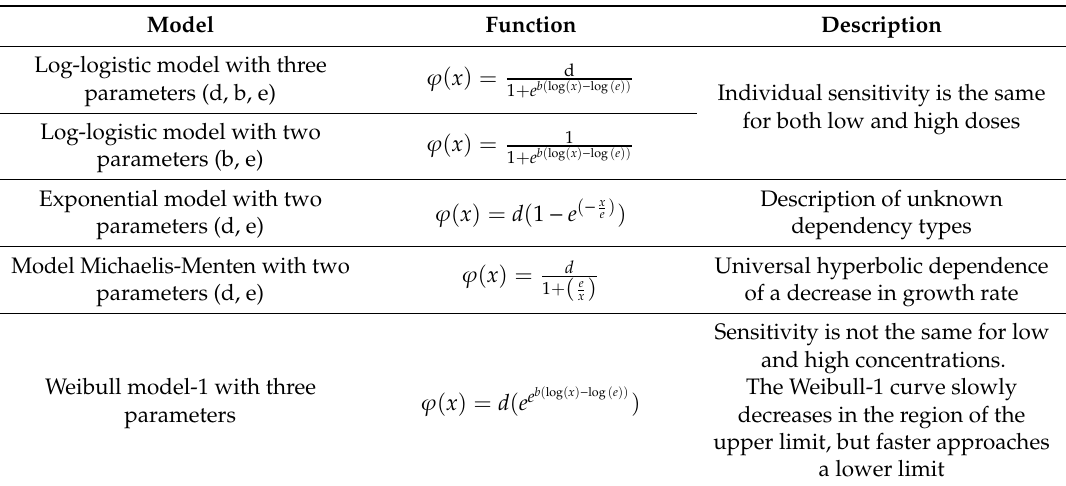
Table 4. Description of some response curves used to describe antimicrobial